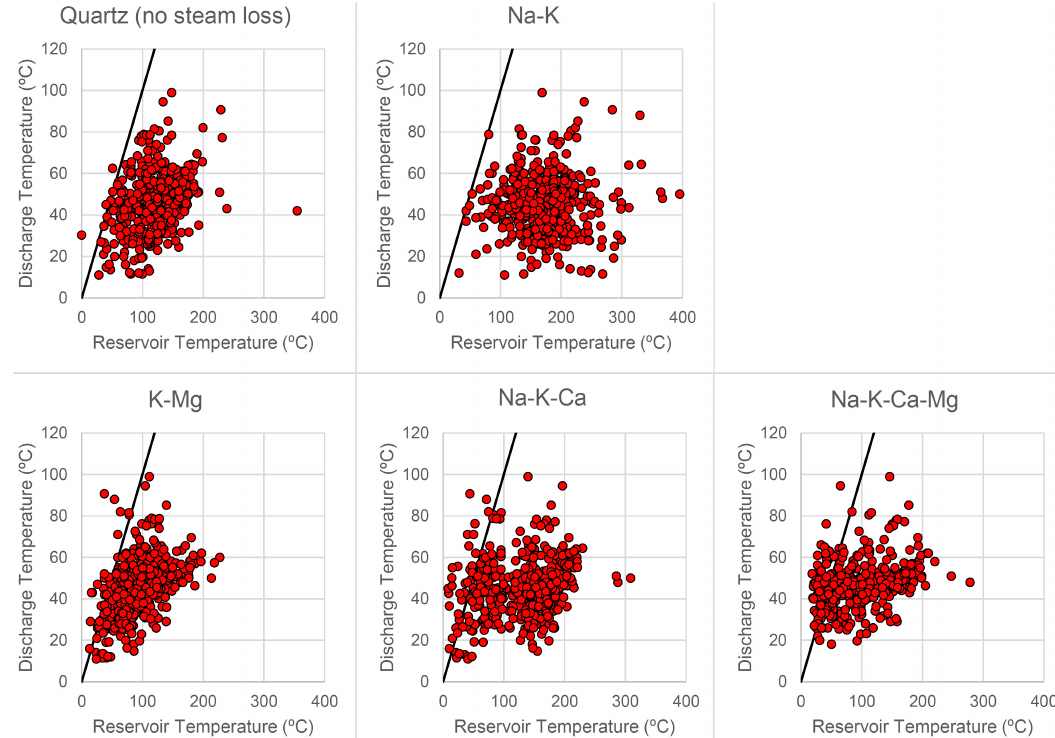
Figure 4. Comparison of major solute geothermometers and spring temperatures. Horizontal axis plots the reservoir temperatures estimated by the geothermometers and the vertical axis plots the discharge temperatures of the hot springs. Black line indicates the linear y = x line.